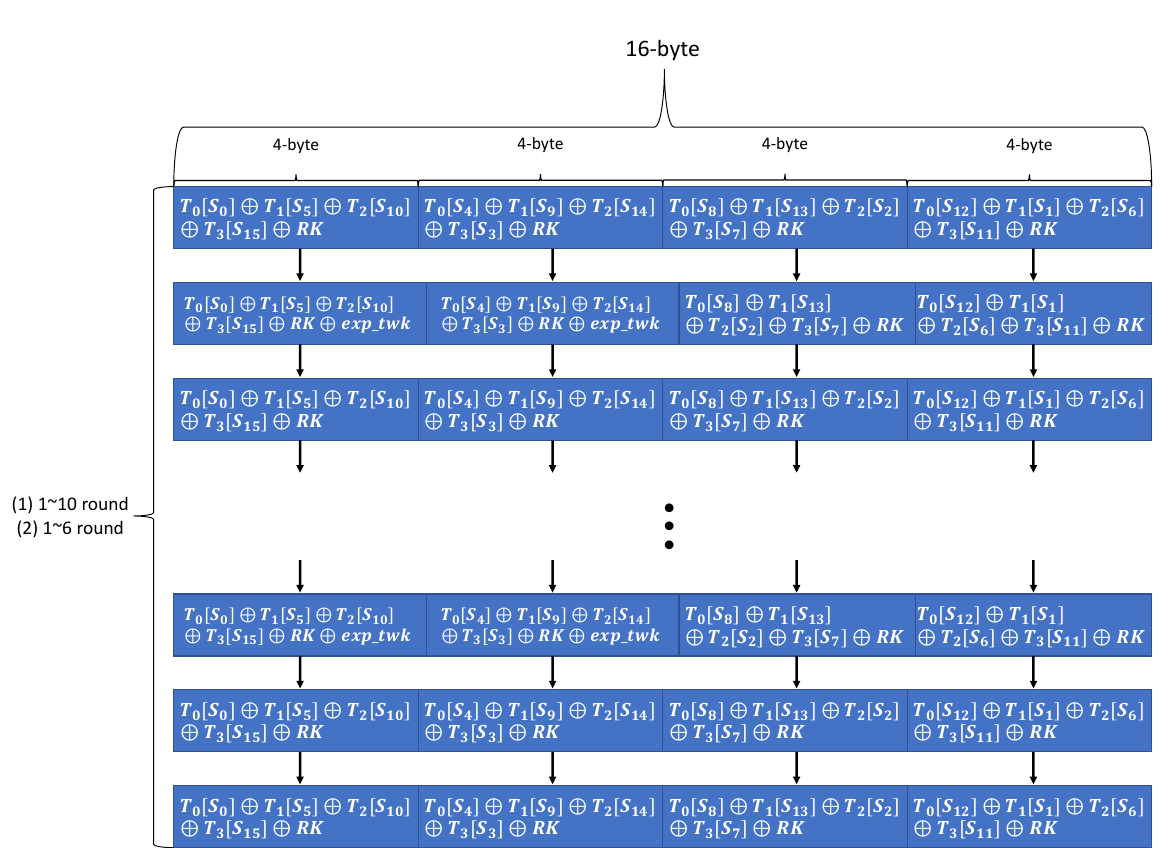
Figure 14. Parallel operation process of TweAES-128 or TweAES-128-6 using T-table method.